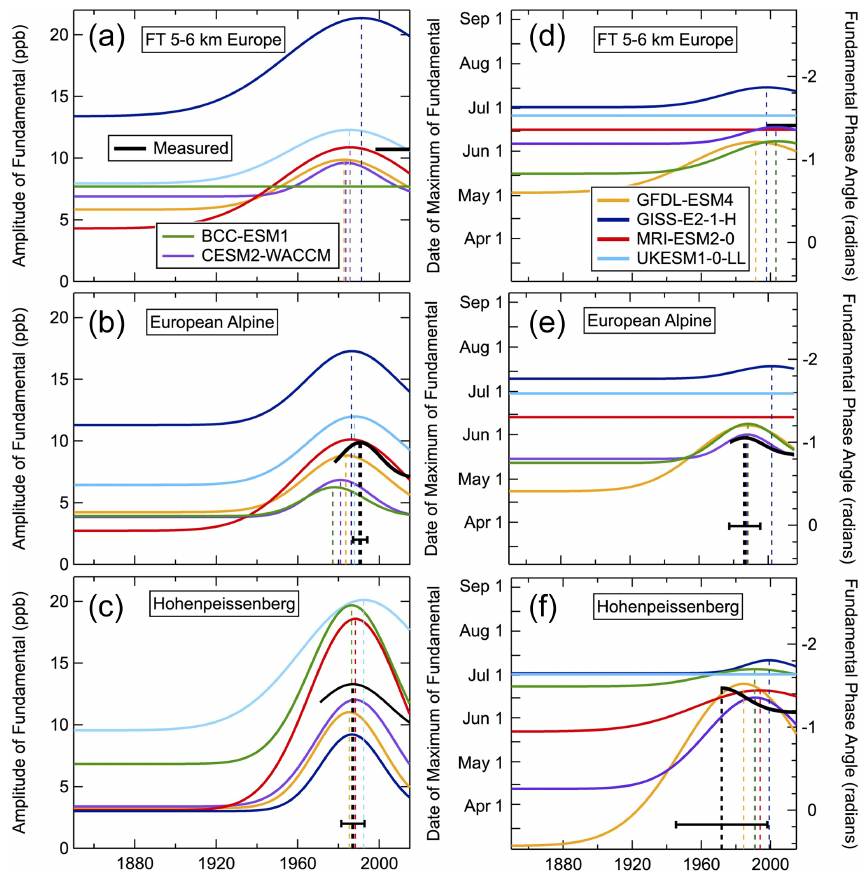
Figure 5. Shift in the seasonal ozone cycle at the three European locations represented by changes in parameter values fit by the Gaussian functions of Eq. (4). Colors identify the respective model simulations, and measurements are shown in black. From bottom to top, the panel positions correspond to relative elevations. The left and right panels quantify the respective amplitude and phase of the fundamental as a function of year. The left axes of the right panels give the date of the seasonal maximum, while the right axes show corresponding values of the phase in radians. Dashed lines extend from the maximum value of the Gaussian function to the x axis, indicating the m and m ϕ parameters; associated error bars indicate confidence limits of the parameters derived from the